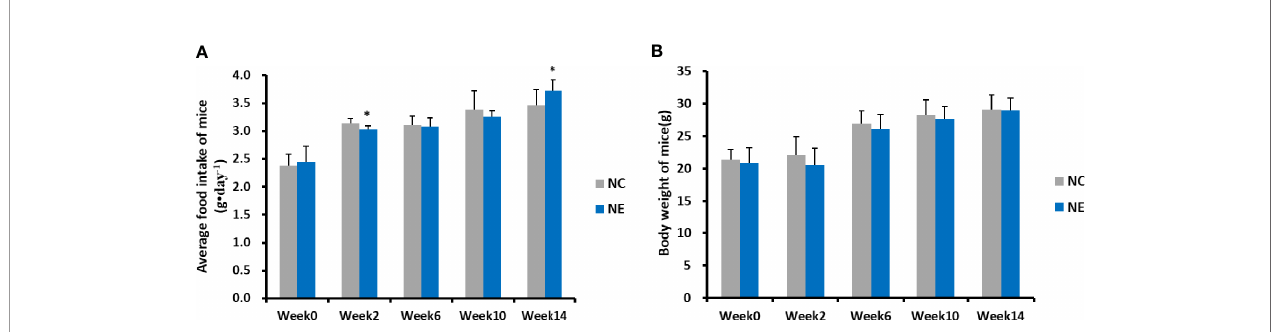
FIGURE 1 | Average food intake of mice (g (cid:129) day − 1 ) and body weight of mice (g). Repeated-measures ANOVA was used to compare the groups. (A) average food intake of mice (g (cid:129) day − 1 ). (B) body weight of mice (g). NC = control group; NE = exercise group. Compared with the NC group, *p <